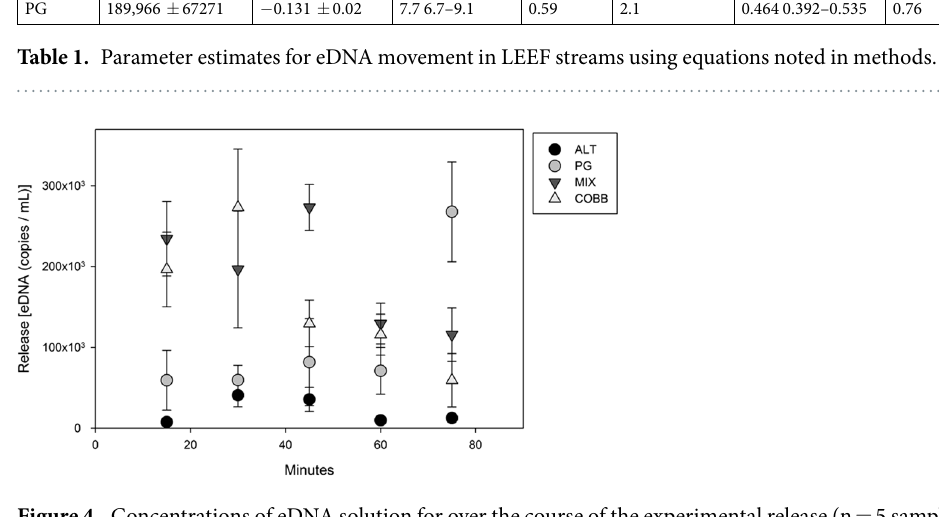
Figure 4. Concentrations of eDNA solution for over the course of the experimental release (n = 5 samples per stream; standard error bars represent 3 analytical replicates per sample). We found no statistical evidence of degradation in any stream (linear regression, p <